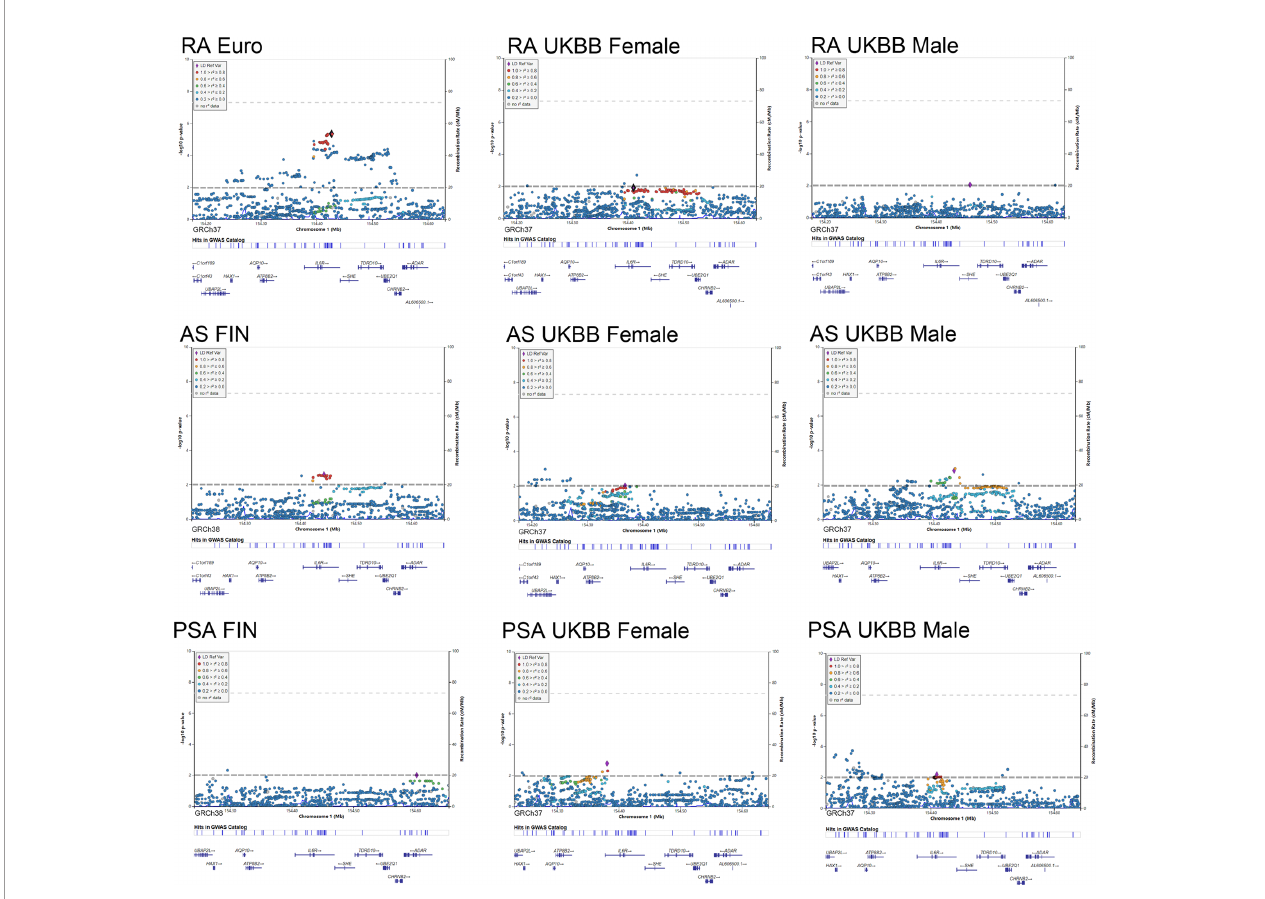
FIGURE 5 | Regional plot of the genetic variants at 1q21.3 and their association with autoimmune